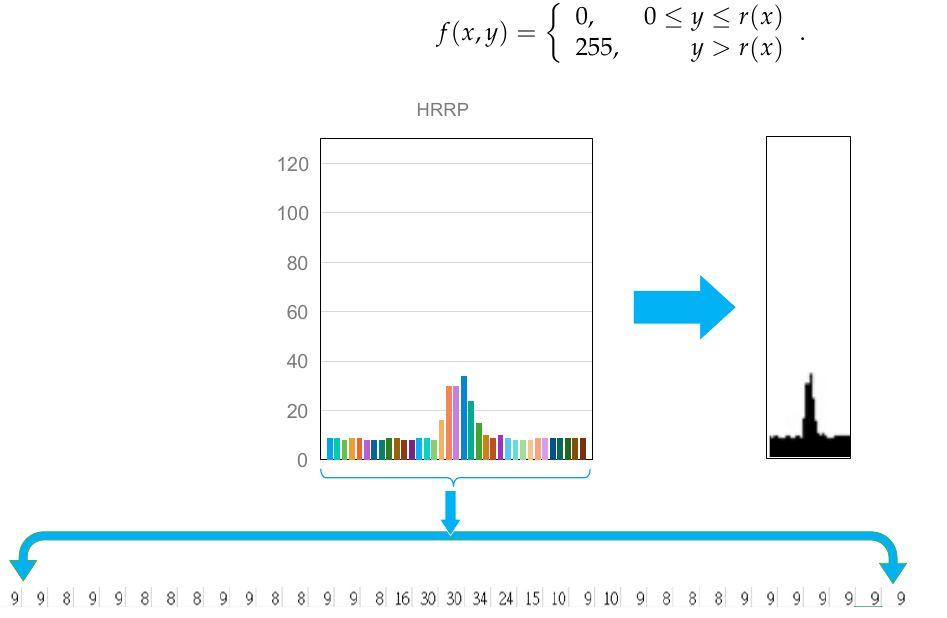
Figure 2. Schematic of the two-dimensional binary map high-resolution range profile (HRRP) data format.